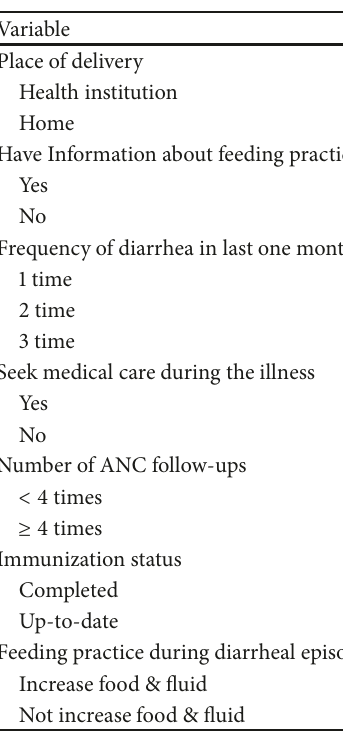
Table 2: Health related condition of study population in Mirab Abaya district, Gamo Gofa Zone, SNNPR, March 2016.